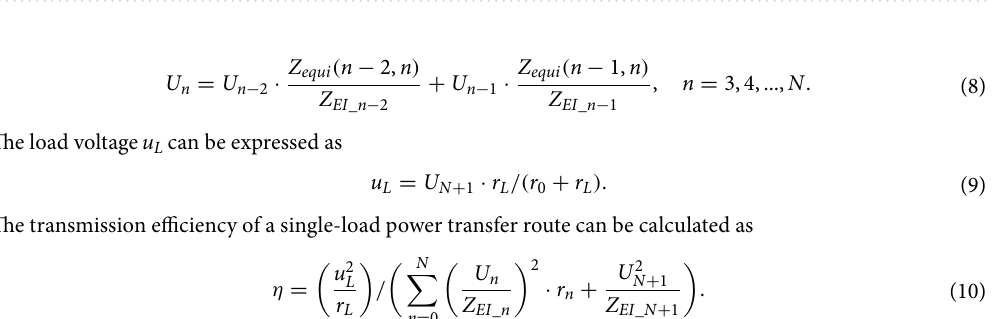
Figure 3. The equivalent circuit diagram of a power transfer route that splits once to reach two